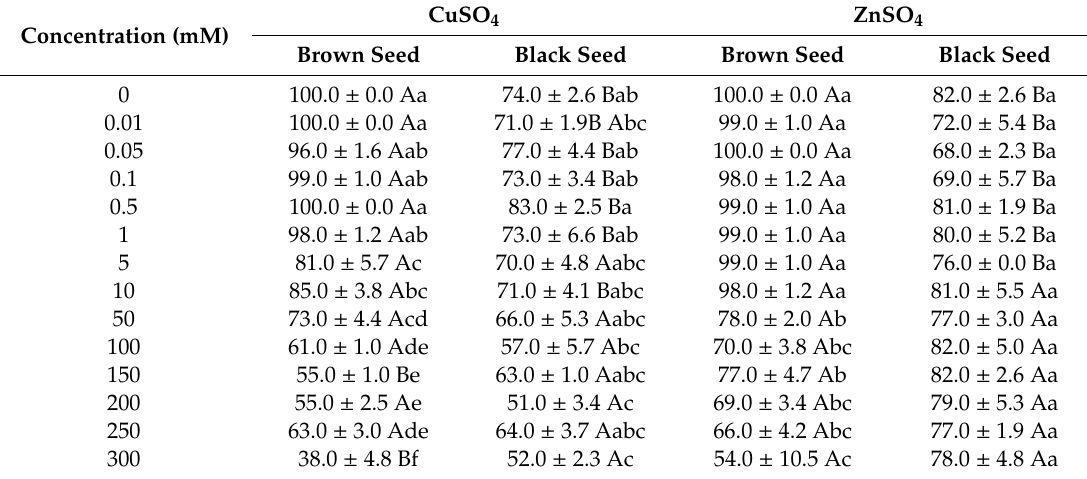
Table 2. E ff ect of CuSO 4 and ZnSO 4 on germination percentage of dimorphic seeds of S. salsa